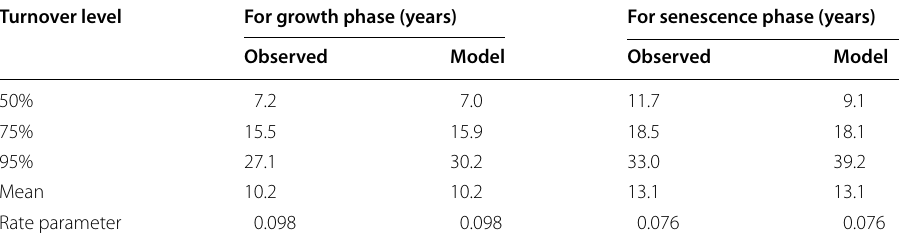
Table 3 Years required for 50, 75 and 95% membership turnover in the 1980 U.S. Senate in the Growth and Senescence Phases of the population life cycle model including years observed as well as years predicted by the Exponential model using the inverse of the means as the exponential